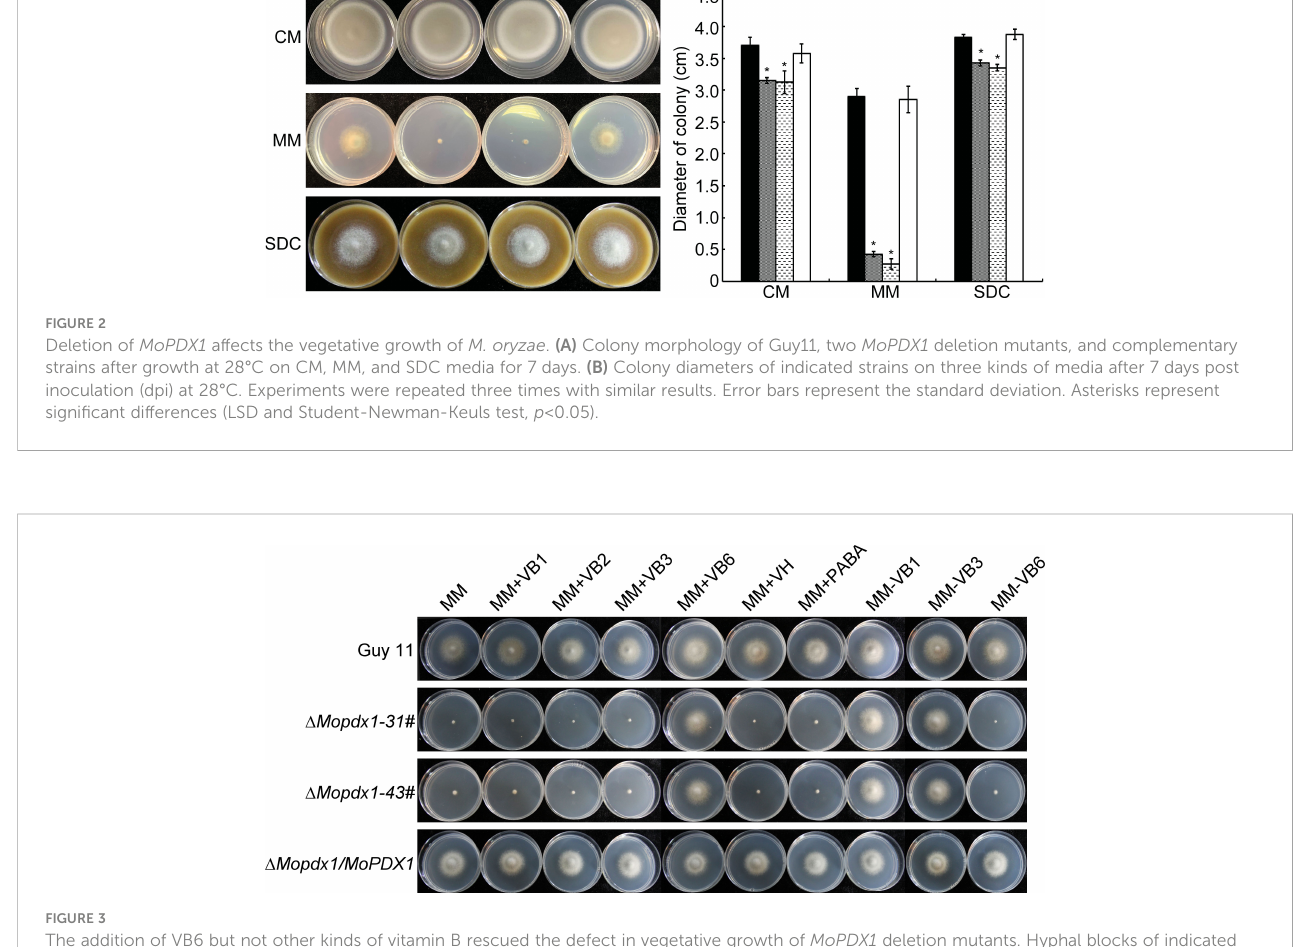
TABLE 1 Statistical analysis of the wild type, D Mopdx1 mutants, and the complement strains on MM media with different types of vitamin B. Strains